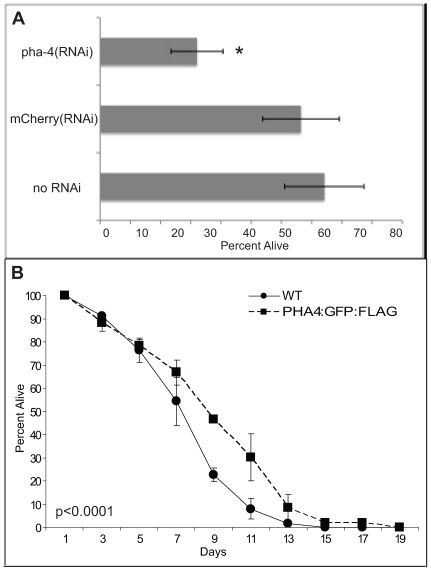
PHA-4 is required for starvation survival.(A) Loss of pha-4 leads to reduced starvation survival of first stage (L1) larvae. Wild-type (WT) worms were soaked in no RNAi, Cherry double-stranded RNA (dsRNA), or pha-4 dsRNA without food for the indicated times. To determine viability, triplicate samples were transferred to plates with food. Numbers of worms surviving past L1 were counted after 2 days. Results are an average of three independent experiments, n = 300–500 worms counted for each strain per experiment, error bars represent standard error. * = p<0.05. (B) Overexpression of pha-4 increases L1 starvation survival. PHA-4:GFP and outcrossed WT worms were subjected to starvation in liquid. Survival was determined as in (A). Results are an average of two independent experiments, n = 500–1900 worms counted for each strain per experiment, error bars represent standard error, p<0.0001 log rank (Mantel-Cox) test.